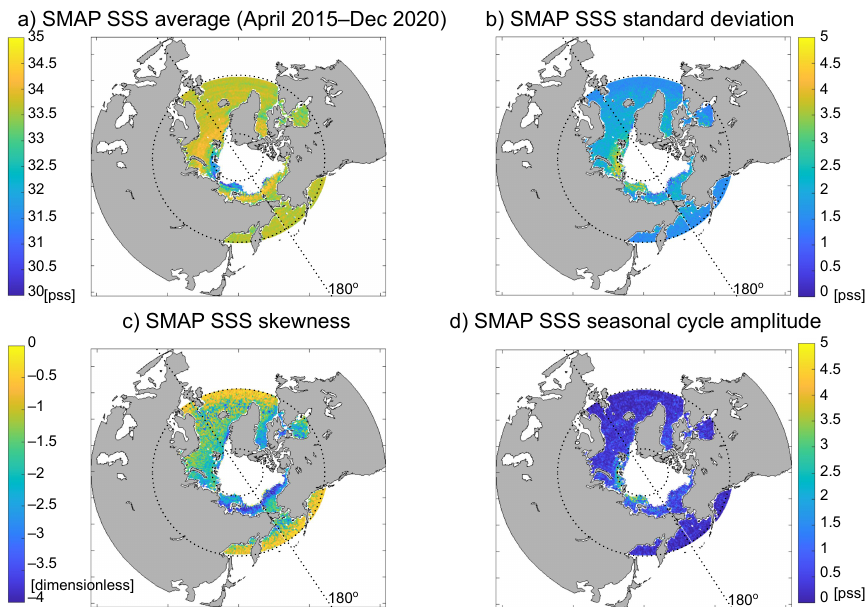
Figure 3. Statistics for SMAP Level-2 sea-surface salinity (SSS) product for the period April 2015 to December 2020: ( a ) SSS average, ( b ) SSS standard deviation, ( c ) SSS skewness, and ( d ) SSS seasonal cycle amplitude. The standard deviation and skewness are computed after the removal of the seasonal cycle and trend. The maps synthesize the SMAP data without interpolation, but average all data over each nearest 50 km by 50 km grid point and over each 8-day time period. Overlaid on top are geographical coordinates indicating where the 0 ◦ and 180 ◦ meridians, as well as the 55 ◦ N and 80 ◦ N latitudes are.